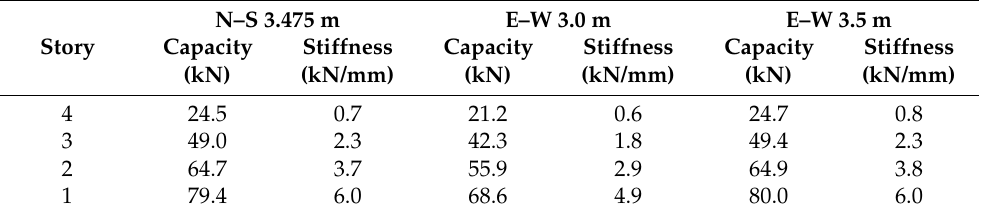
Table 8. Maximal shear capacity and lateral stiffness of the shearwall segments of the long modules.